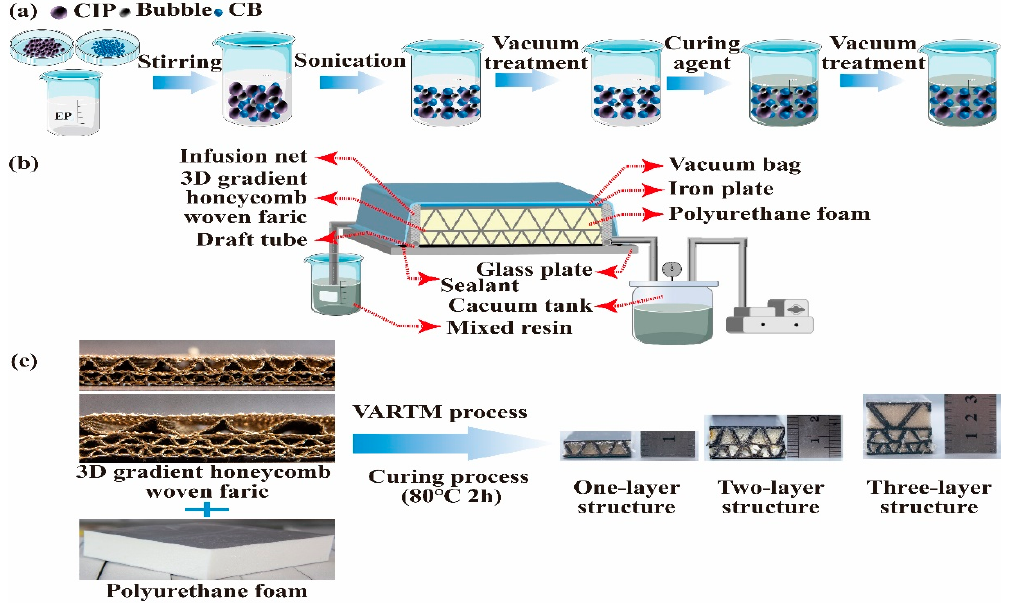
Figure 3. ( a ) Illustration of the microwave-absorbing resin preparation; ( b ) schematic of VARTM process; ( c ) the fabrication procedure and the physical maps of 3D GHWCs with triangular sections. Table 2. Physical parameters of 3D GHWCs with triangular sections.